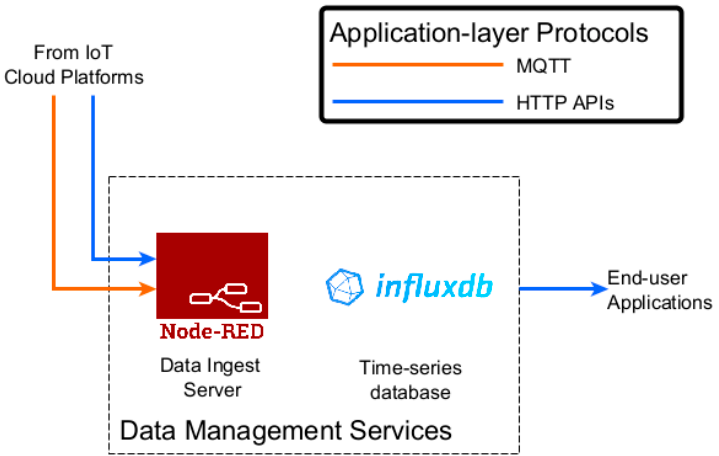
Figure 2. A system architecture to demonstrate data management services.